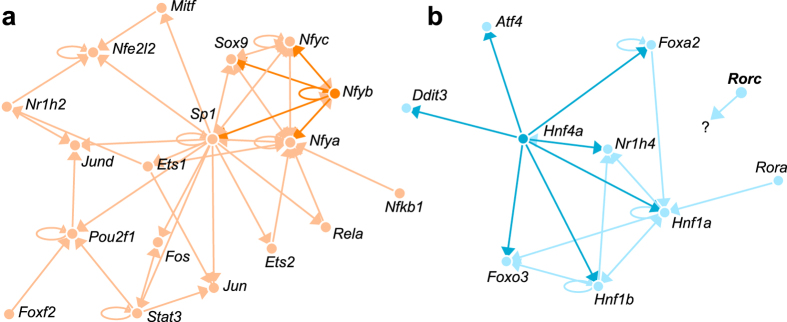
Transcription factor enrichment confirms increased unfolded protein response (UPR) and metabolic decline in runts.(a) A network of interactions between selected enriched TFs with increased activity visualized using the Interactome tool. Strong orange colour emphasizes a subcluster of enriched TFs with known involvement in UPR. (b) Network of interactions between selected enriched TFs with decreased activity. Dark blue colour designates TFs regulated by HNF4A.